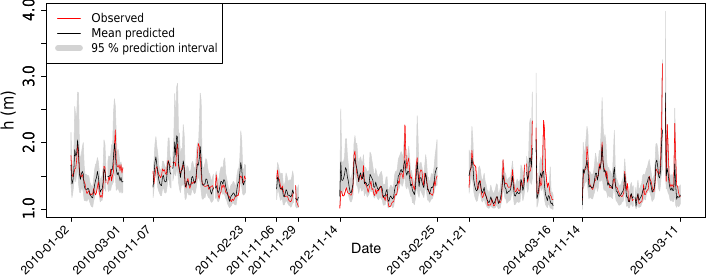
Figure 8. Validation time series of the conditional model obtained by 6-fold cross-validation. h obs is shown in red. The average and 95% prediction intervals of 10 4 simulated time series are respectively shown in black and